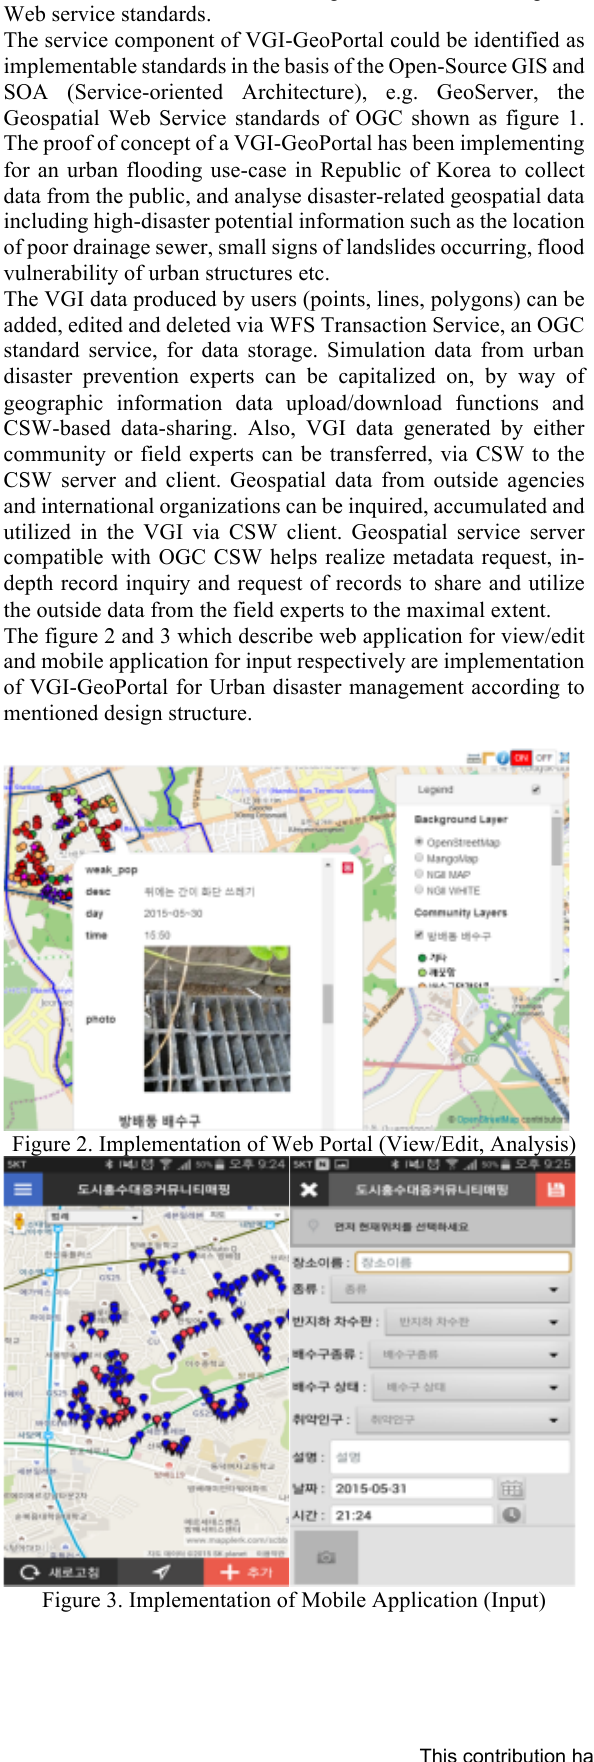
Figure 3. Implementation of Mobile Application